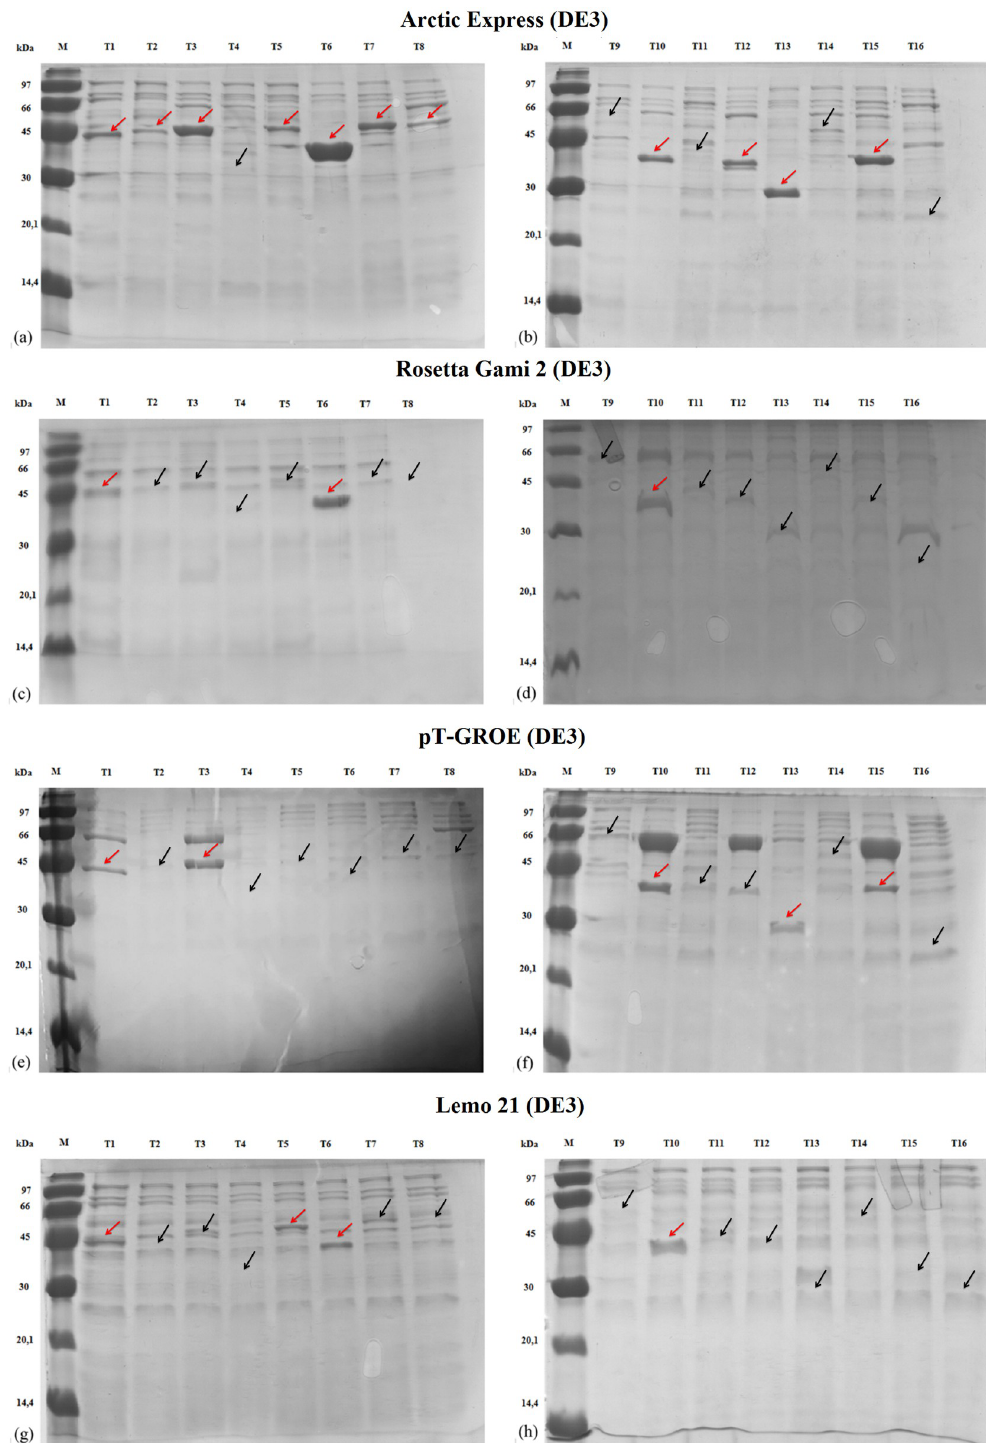
Fig 2. SDS-PAGE (15%) analysis of soluble protein recovery after affinity chromatography in the four strains used in this work. The red arrows indicate the recovered protein with the correct molecular weight. The black arrows indicate the molecular weight of the proteins that were not recovered or only minimally recovered.